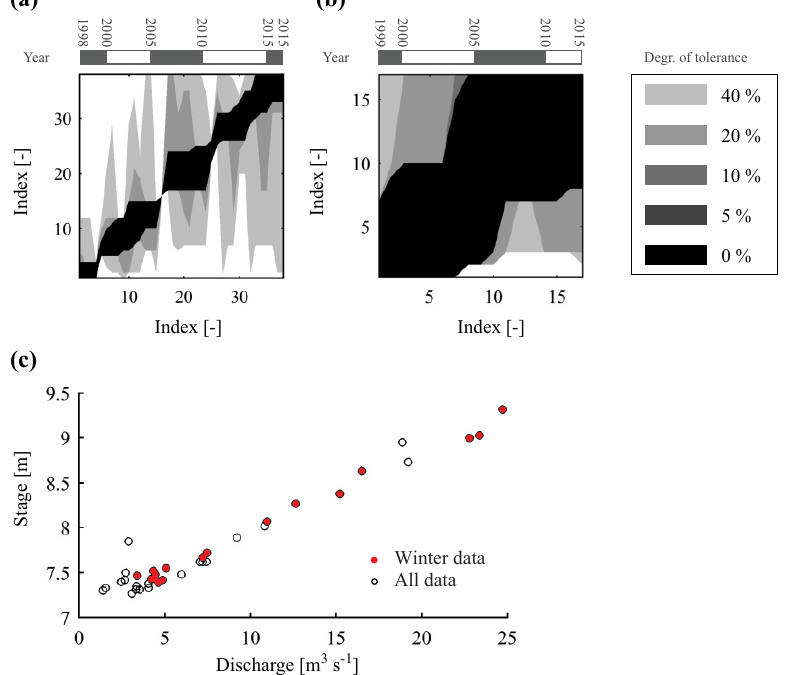
Figure 11. Combined BReach t_2s plot with (a) all data and (b) only winter data for Hulshout. In all subplots, for each index on the x axis the gray area indicates the span between the index of the maximum left reach (under the bisector) and the maximum right reach (above the bisector). Each gray tint represents a different degree of tolerance (i.e., percentage of data points allowed to have nonacceptable model results). (c) Stage–discharge data for